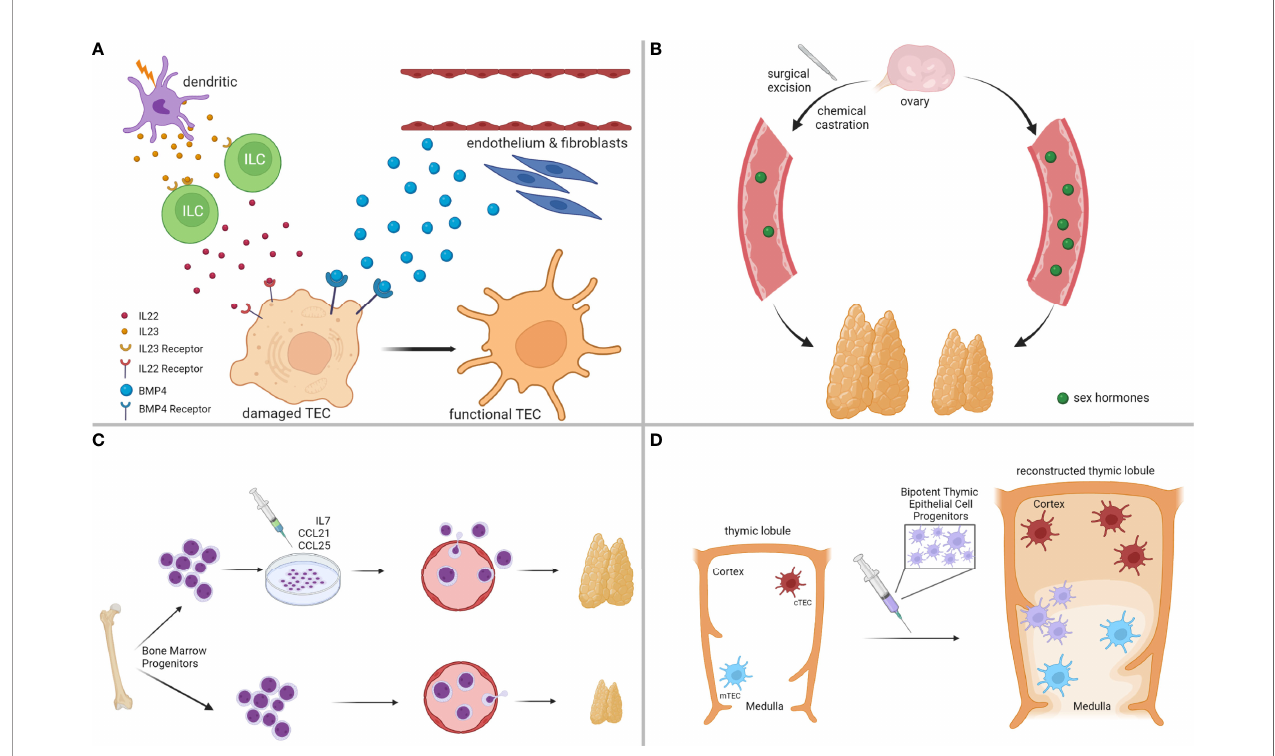
FIGURE 3 | Strategies for Enhancing Thymus Regeneration Following Chemotherapy. (A) Examples of thymus regeneration strategies targeting thymic stromal cell networks activated in endogenous thymic repair. (B) Examples of thymus regeneration strategies targeting negative feedback loops on thymus size/function from sex hormones. (C) Examples of thymus regeneration strategies involving the transplantation of (pre-conditioned) bone marrow-derived thymocyte progenitors. (D) Examples of thymus regeneration strategies that are not dependent on the endogenous thymus, such as transplantation of bipotent thymic epithelial cell progenitors to reconstitute thymus lobules and functions. Illustration designed with Biorender